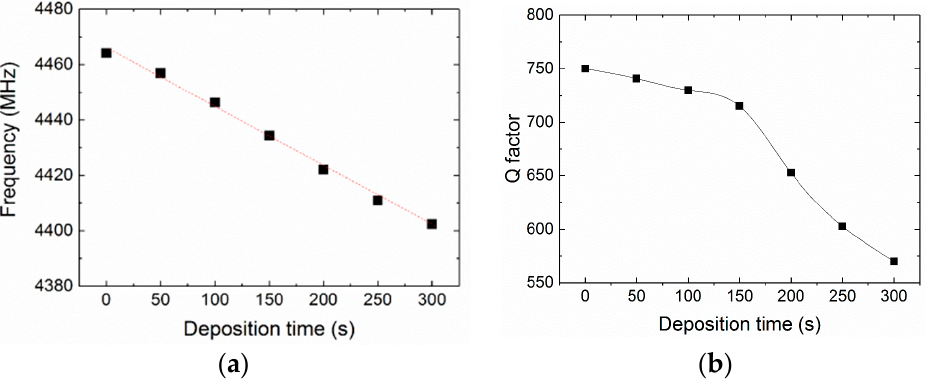
Figure 5. The admittance curves of the bare FBAR device and PEI nanofibers-coated FBAR devices. The times of electrospinning deposition were 50–300 s.